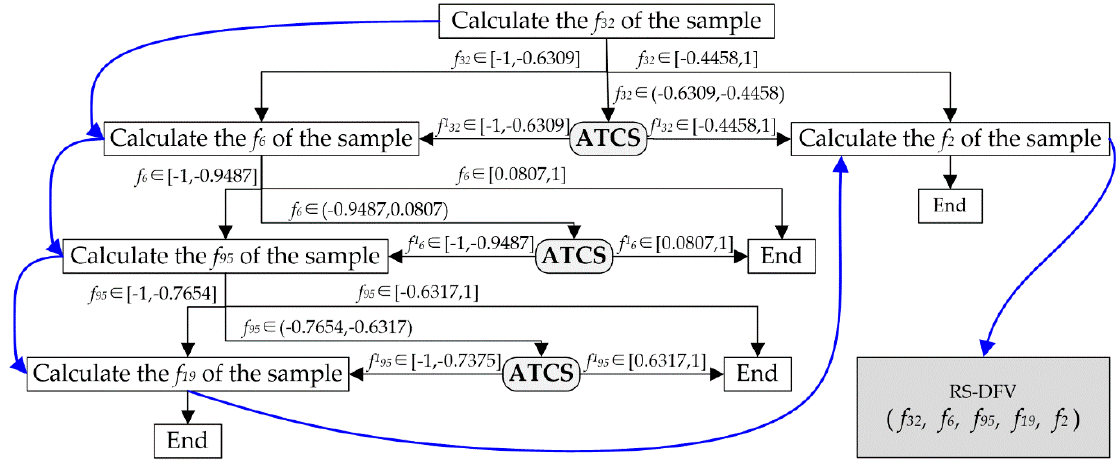
Figure 14. The RS-DET of the REB faults.